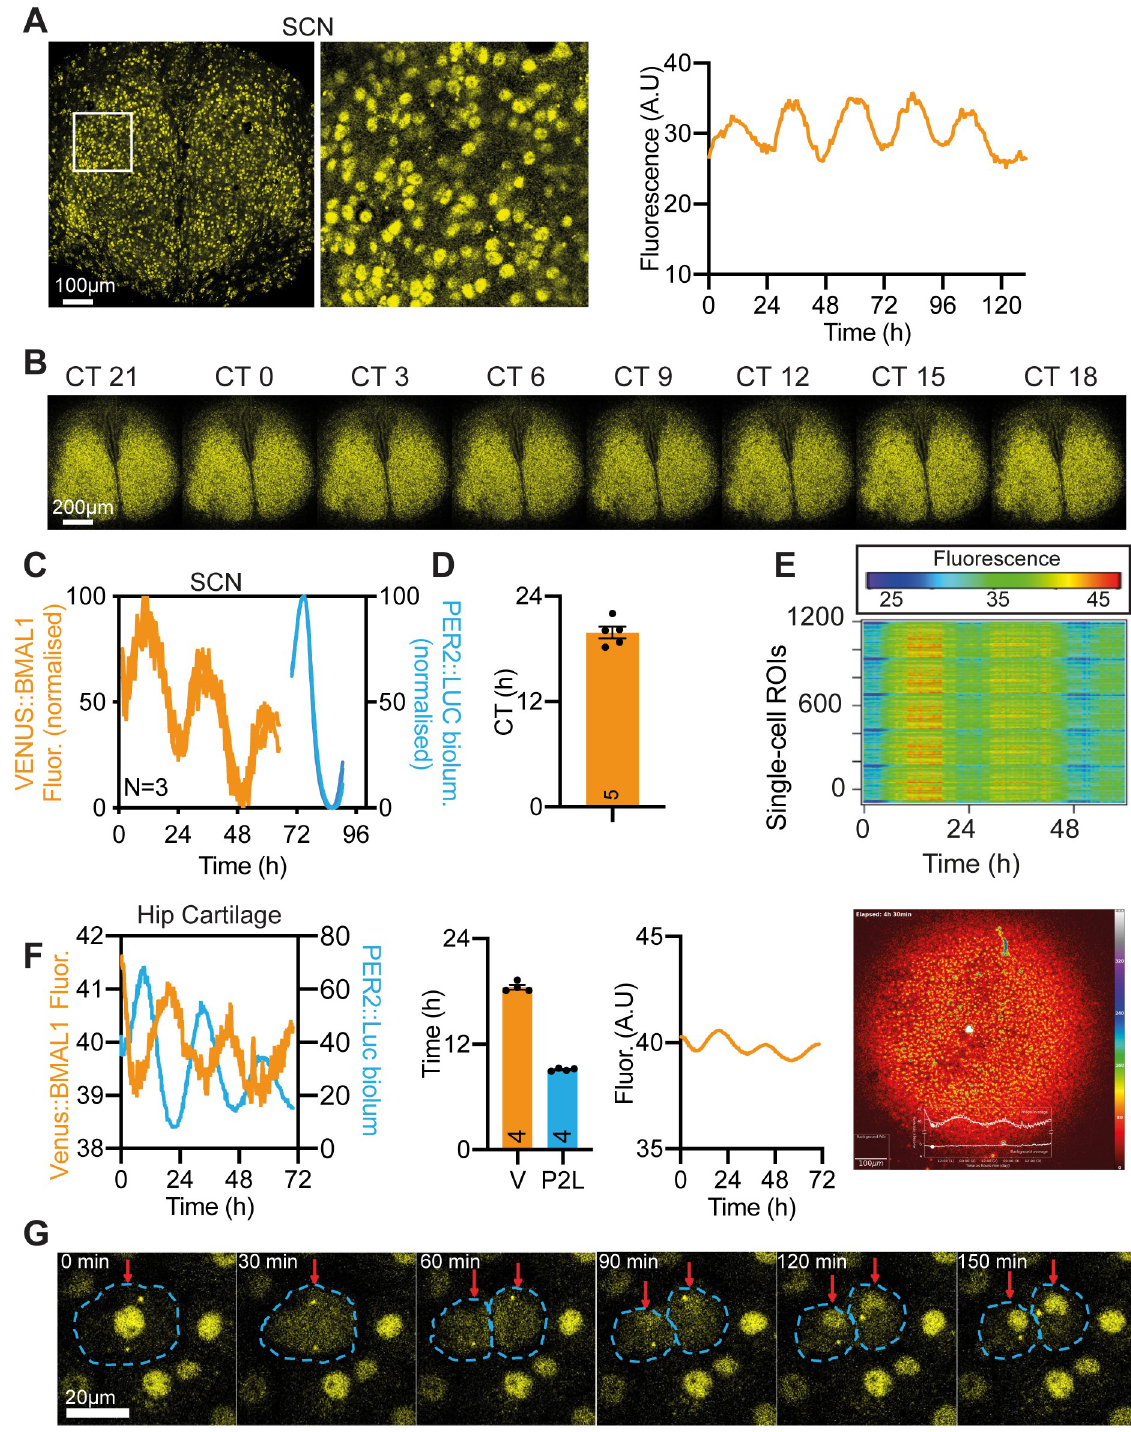
Fig 3. Real-time imaging of the dynamic behaviour of Venus::BMAL1. A) Representative confocal snapshot from live imaging of Venus:: BMAL1 in an SCN organotypic slice with associated close-up image (centre, white box), and with background subtracted (BGS) average fluorescence signal over the course of the 6 days of recording (right). B) Montage showing Venus::BMAL1 fluorescence snapshots from a representative SCN slice across the circadian day (with circadian time back-calculated from PER2::Luc rhythms). C, D) Peak fluorescence of Venus::BMAL1 in the SCN was antiphasic to PER2::Luc, with peak mean ± SEM CT of 19.9 ± 0.66 hours (PER2::Luc peak set as CT12; n = 5 animals). Normalised, consecutive Venus::BMAL1 and PER2::Luc time-lapse recordings within the same 3 SCN slices used for